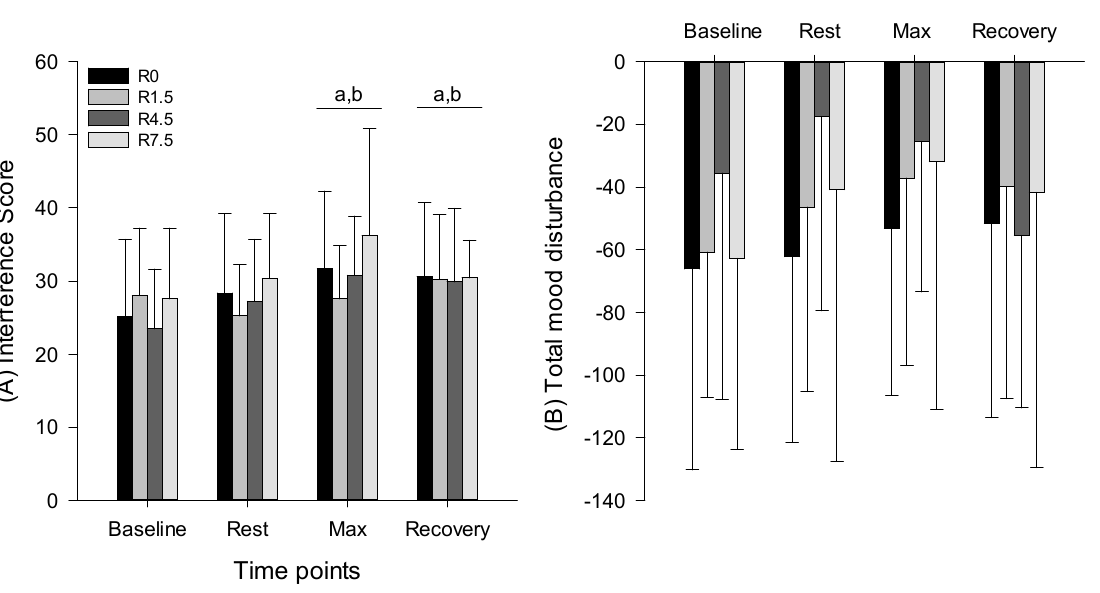
Figure 2. ( A ) Interfere score for the Stroop color–word test and ( B ) total mood disturbance during rest and maximal cycling exercise. a p ≤ 0.05 vs. baseline; b p ≤ 0.05 vs. resting in hypoxia. The TMD indicated no main effect for time (F = 1.413, p = 0.263, power = 0.326), no main effect for condition (F = 1.117, p = 0.362, power = 0.263), and no interaction (F = 1.407, p = 0.201, power = 0.629) (Figure